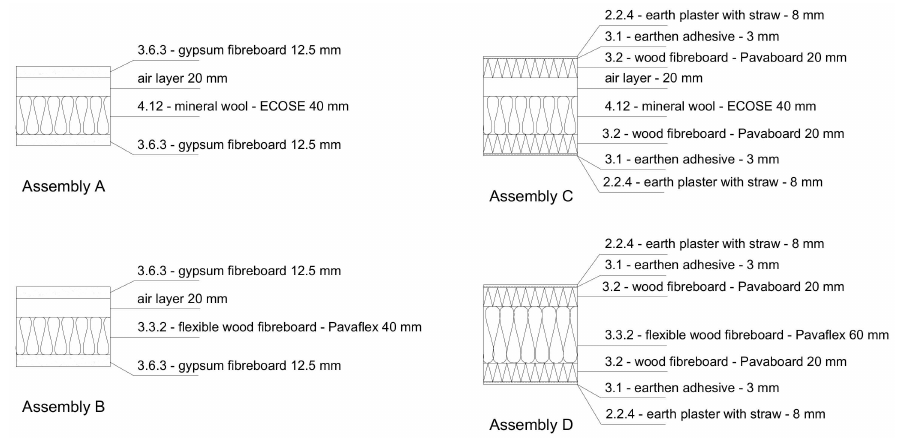
Figure 1. Investigated wall assembly samples.